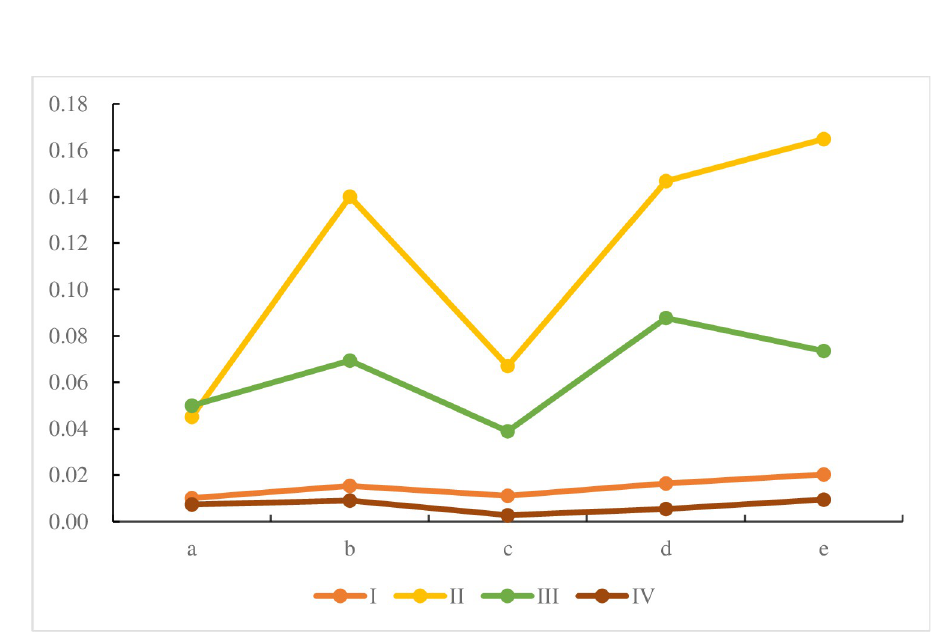
Fig 4. Evaluation results of second-level index.